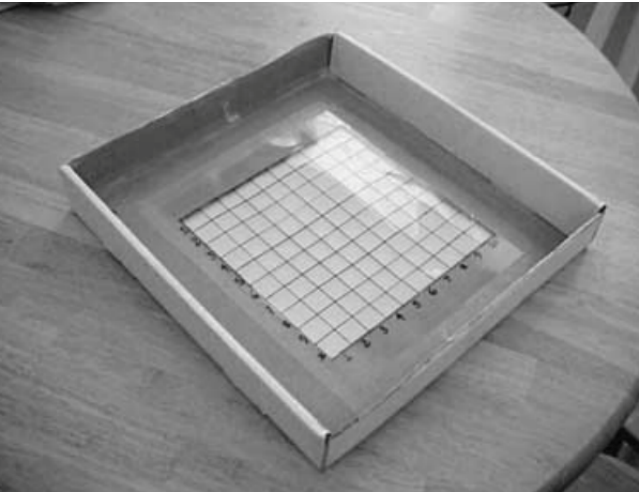
Figure 4. Buonaccorsi and Skibiel [57] drop split peas on a quadrat on a screen using an overhead projector. “A 20 cm × 20 cm grid comprised of one hundred 2 cm × 2 cm quadrats was drawn with